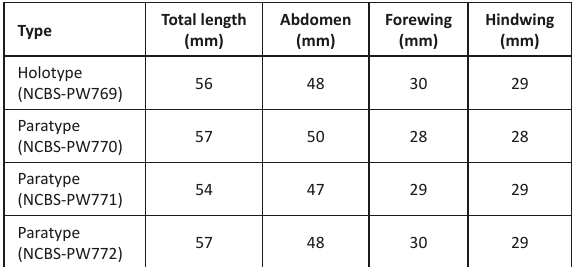
Table 2. Morphometric measurements of type specimens of Protosticta ponmudiensis sp. nov.